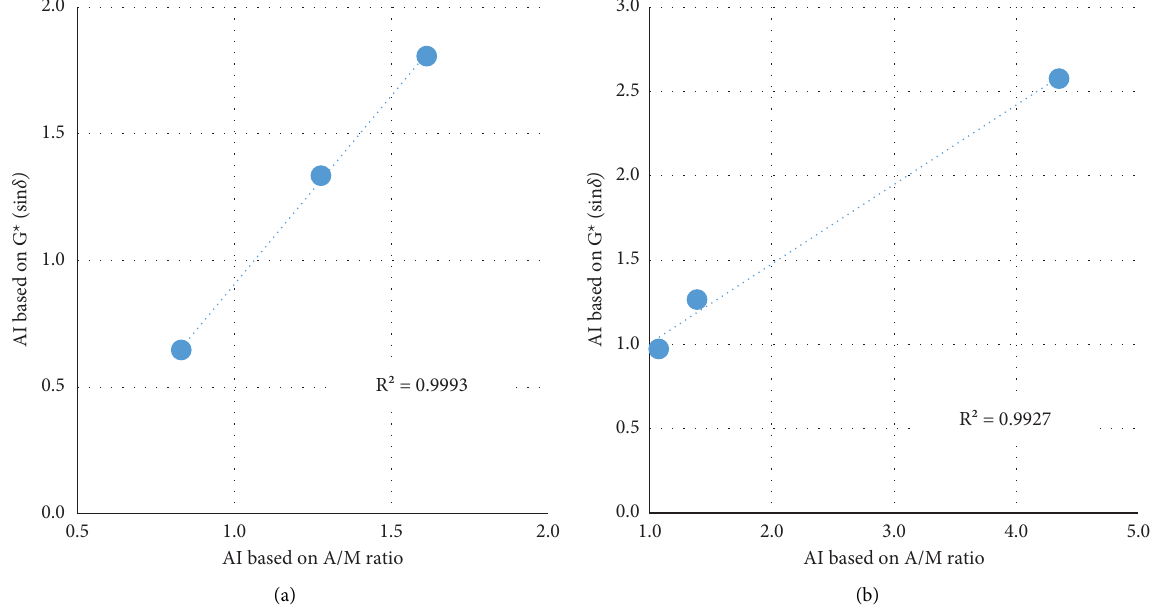
Figure 12: Correlation between ageing indices based on rheological and chemical parameters. Table 6: Percent of the total number of aggregate particles with diferent degrees of coating. % of coating on Coating